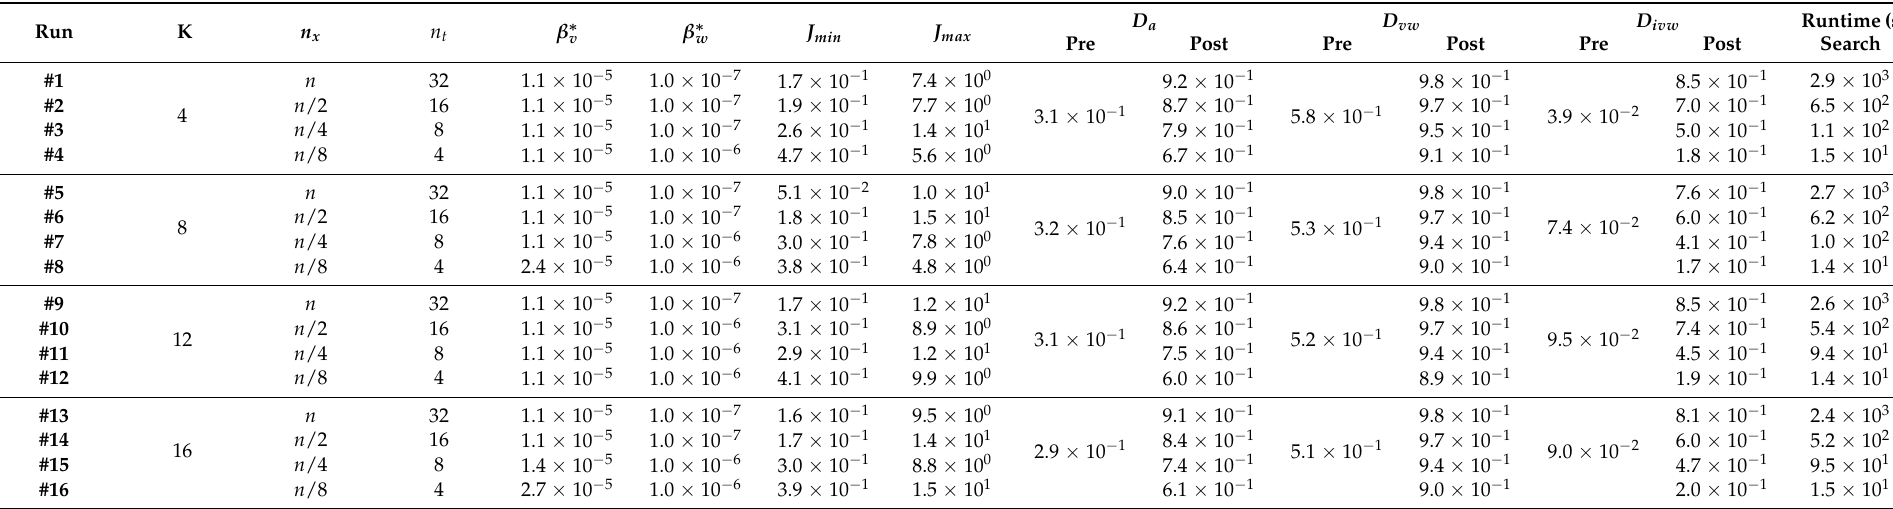
Table 5. Experiment 2A: Registration performance for CLAIRE for case 1 ( n t changes proportionally to the image resolution, see Section 5.3) . Comparison of registration accuracy based on the Dice score at different resolutions for the synthetic dataset SYN. K denotes the frequency of the synthetic velocity field in Equation (12). n = ( 1024,1024,1024 ) is the base image resolution. We fix the tolerance for the reduction of the gradient to 5 × 10 − 2 and use linear interpolation. The Jacobian bounds for the parameter search are [ 0.05,20 ] . We report β ∗ v and β ∗ w (the optimal regularization parameters obtained with the proposed parameter search scheme), and J min and J max (the minimum and maximum values for the determinant of the deformation gradient). For the Dice score, we report average Dice ( D a ), the volume weighted average Dice ( D vw ), and the inverse volume weighted average Dice ( D ivw ), pre and post registration. We also report the wall clock time for the parameter